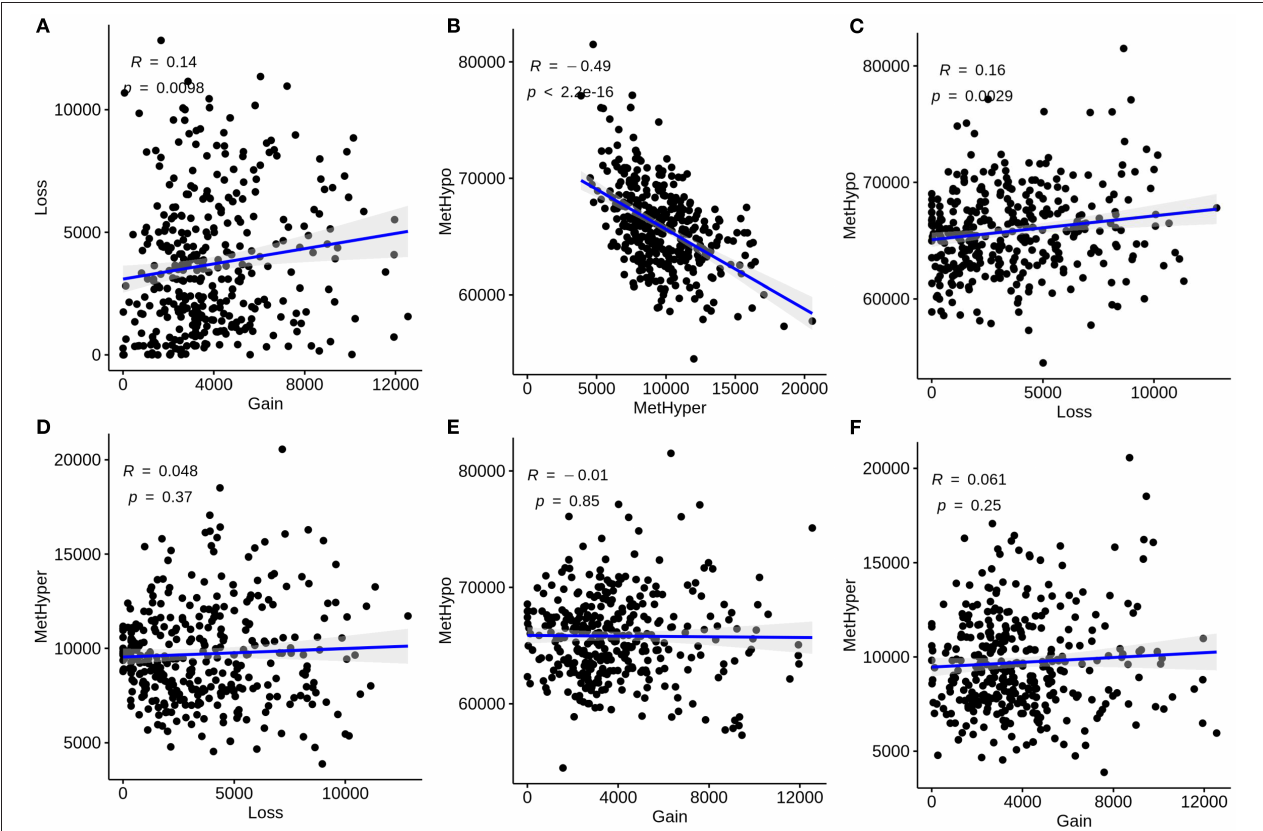
FIGURE 2 | Correlation between CNVs and methylations in liver carcinoma. (A) Correlations of CNV gain with loss. (B) Correlations of MetHypo with MetHyper. (C) Correlations of CNV loss with MetHypo. (D) Correlations between CNV loss and MetHyper. (E) Correlations of CNV gain with MetHyper. (F) Correlations of CNV gain with MetHyper. X axis represents CNV or methylation scores and y axis represents CNV or methylation scores.